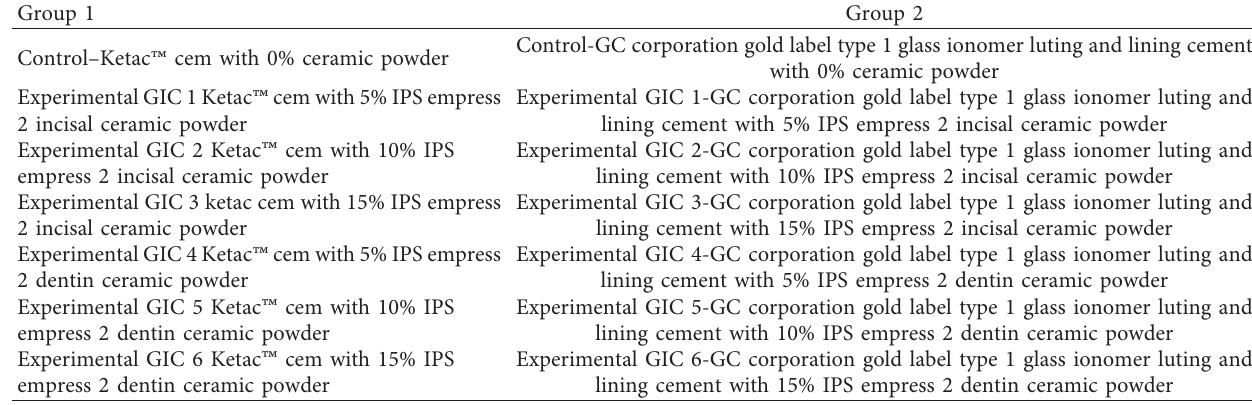
Table 1: Two groups of control and prepared experimental glass ionomer